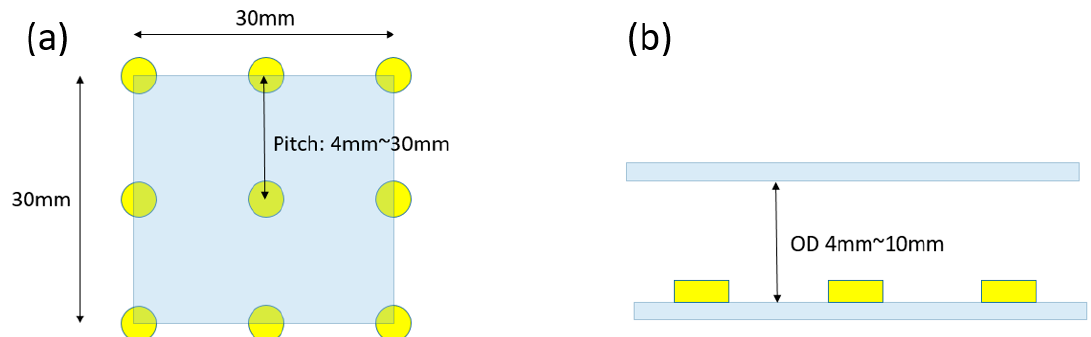
Figure 2. Schematic diagram of ( a ) the Pitch and ( b ) the OD for a backlight module.